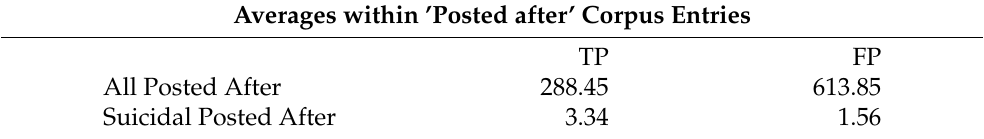
Table 7. Average number of ‘posted after’ and ‘suicidal (as detected by our system) posted after’ messages for the overall numbers of TP and FP ‘posted after’ messages